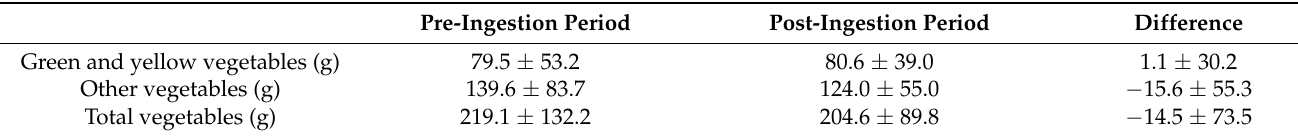
Table 5. Vegetable intake estimated via food